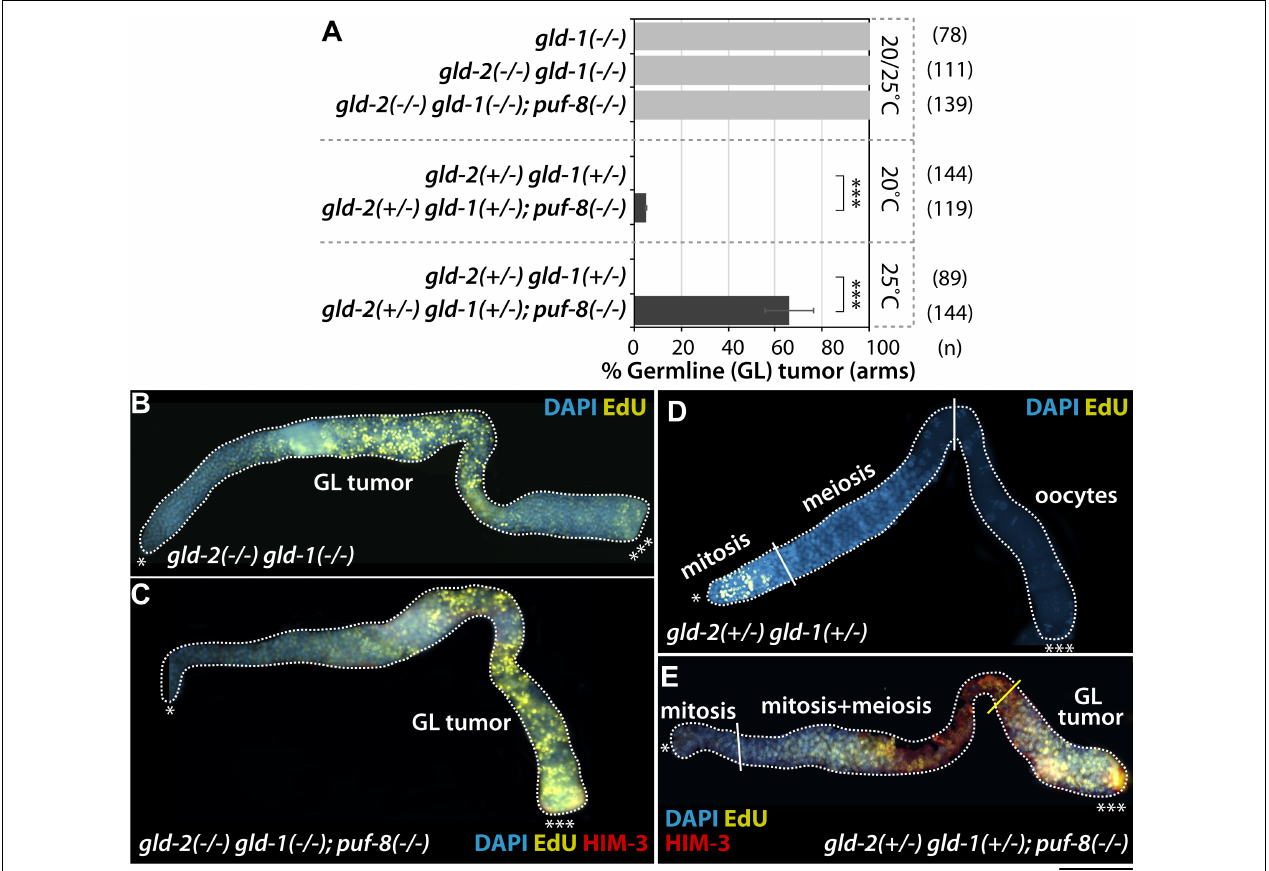
FIGURE 5 | One dose of wild-type gld-1 gene [ gld-1( + / − ) ] promotes the formation of gld-2( + / − ); puf-8(–/–) germline tumors. (A) The percentage of germline tumors at 20 and 25 ◦ C. The germline phenotypes were analyzed at 4 days past L1 stages. (B–E) Staining of dissected adult hermaphrodite germlines. All were stained using EdU-labeling kit (a marker for mitotic cells), HIM-3 (a maker for meiotic cells) and DAPI (a marker for DNA). ∗ Distal end of gonads; ∗∗∗ proximal end of gonads; white broken lines, the boundary of gonad; white lines, the boundary of different germ cell types: mitotic region and meiotic region, meiotic region and oocytes; yellow lines, the boundary between differentiated cells and dedifferentiated EdU-positive mitotic cells. Scale bars, 50 µ m.